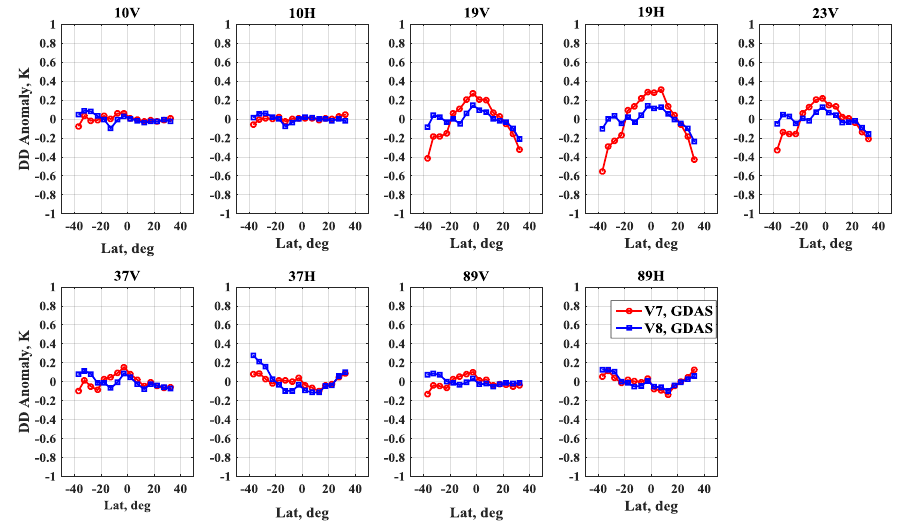
Figure 13. Comparison of latitude dependence of double difference (DD) anomaly for TMI V7 ( red triangles ) and V8 ( green dots ).